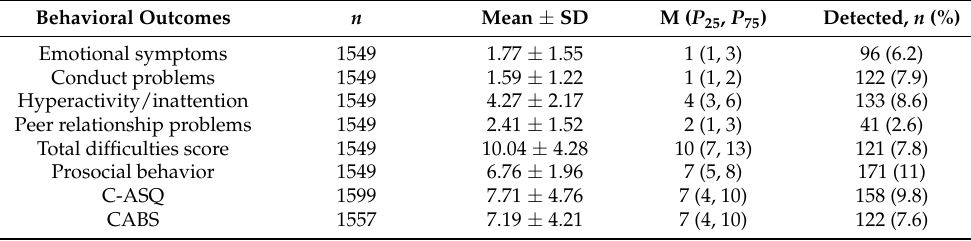
Table 6. Child behavioral outcomes.